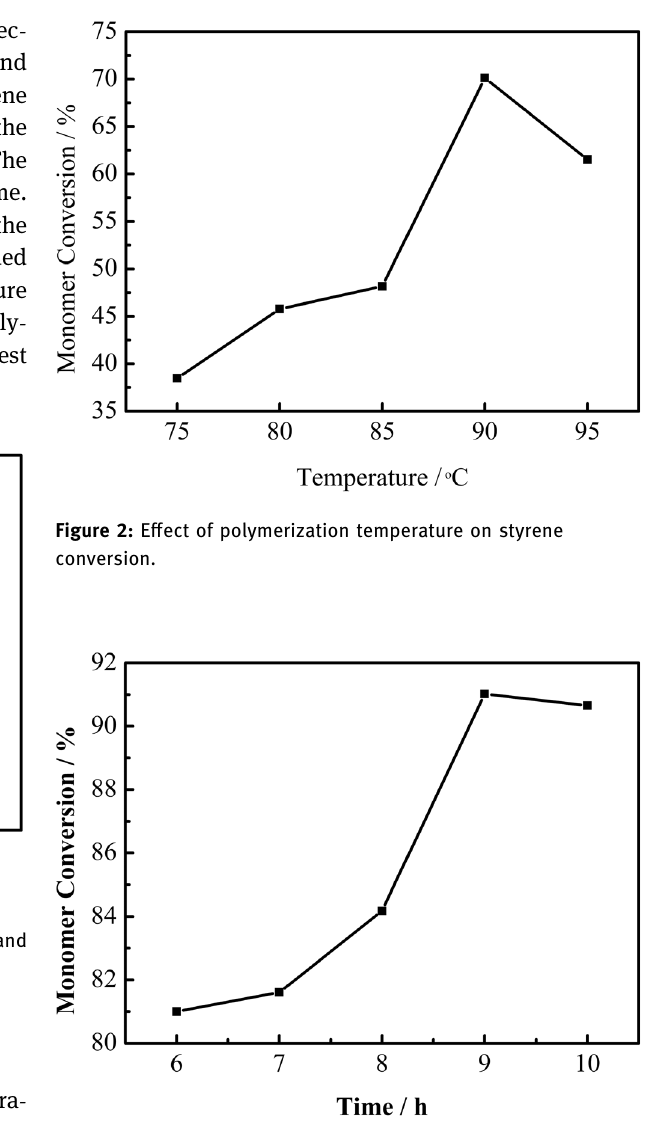
Figure 3: E ff ect of polymerization time on styrene